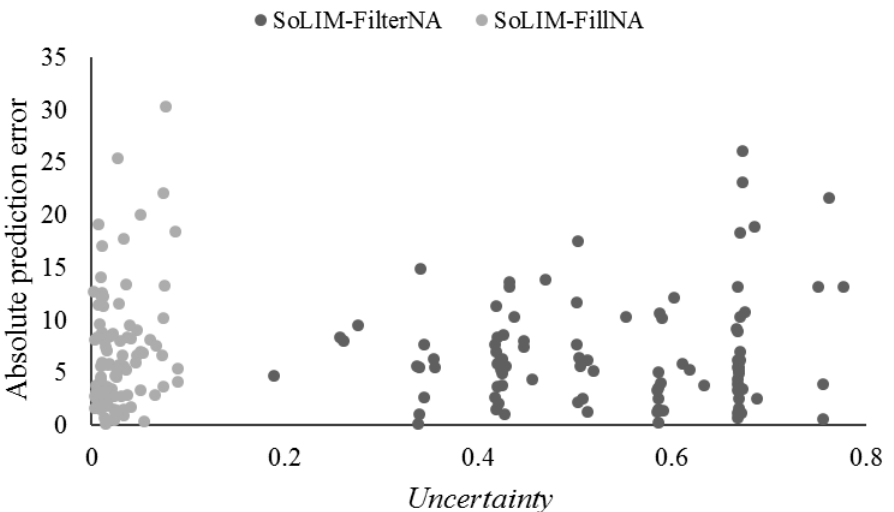
Figure 4. Distribution of prediction uncertainty of evaluation samples derived from SoLIM-FilterNA and the SoLIM-FillNA under the cell-level test scenario and the original SoLIM under the cell-level test scenario T(Vr).